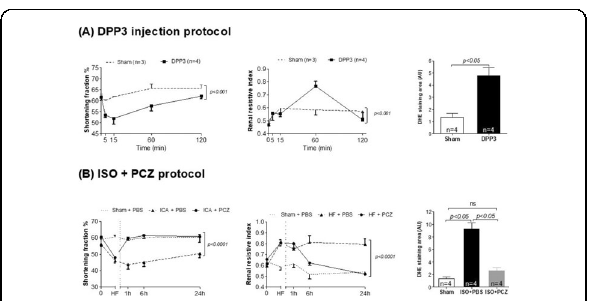
Fig. 1 (abstract 001547). See text for